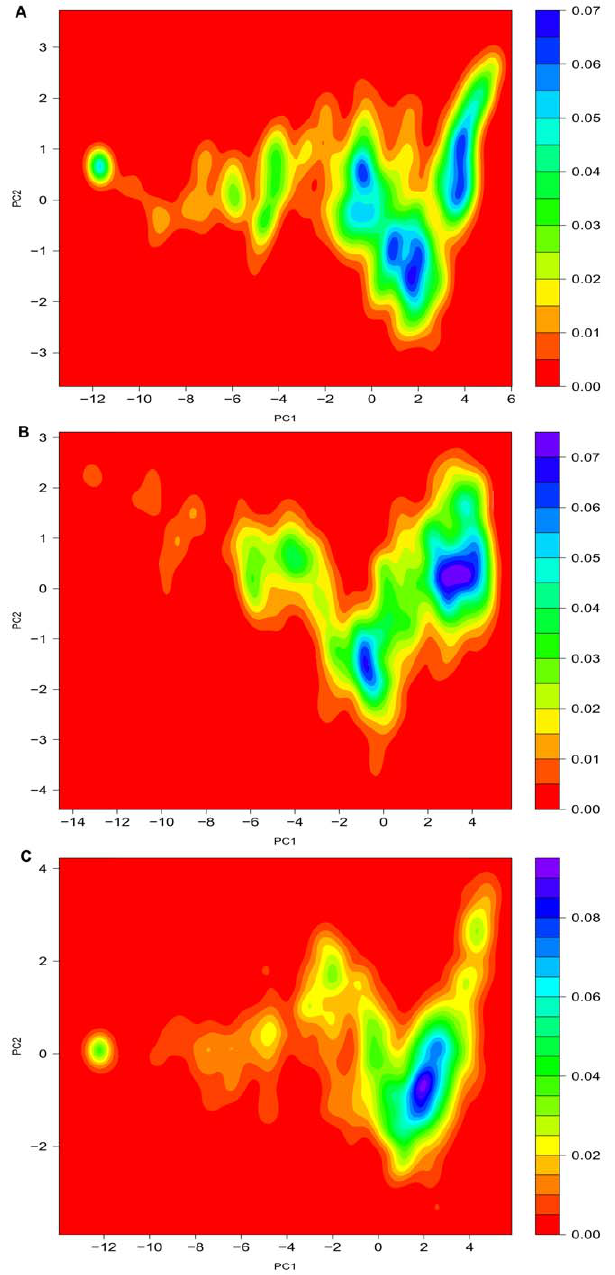
Figure 3. 2D kernel densities of PCA for the PHD2 species unfolding states. The most fold state resides in left side of panels and the most unfold states reside in right side of panels. The densities of a- PHD2, f-PHD2 and fh-PHD2 are depicted in panel A, B and C respectively. The panels are the 2D kernel density maps for the principal components 1, 2. Principal components are computed by utilizing the properties space used to build the d metric. Horizontal and vertical dimensions indicate first and second principal components respectively. The contour levels indicate the density. Darker region is the most populated